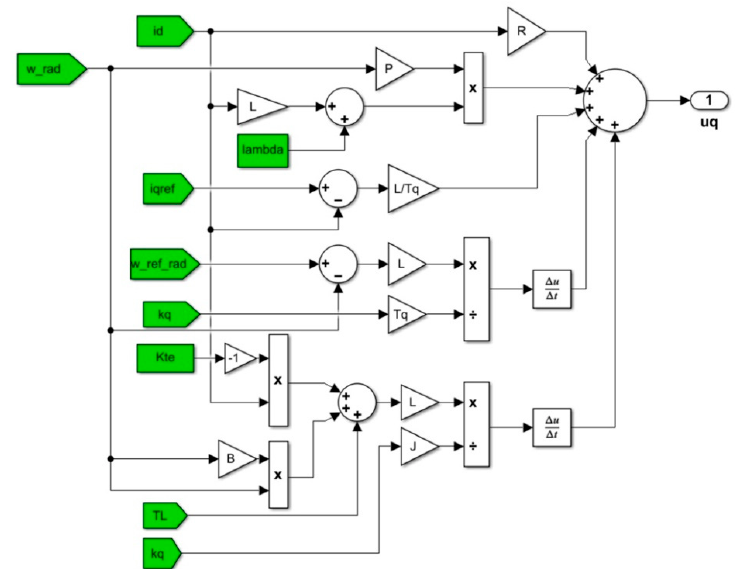
Figure 16. Block diagram of the MATLAB/Simulink implementation for the synergetic current controller of the u q command—Equation (31).